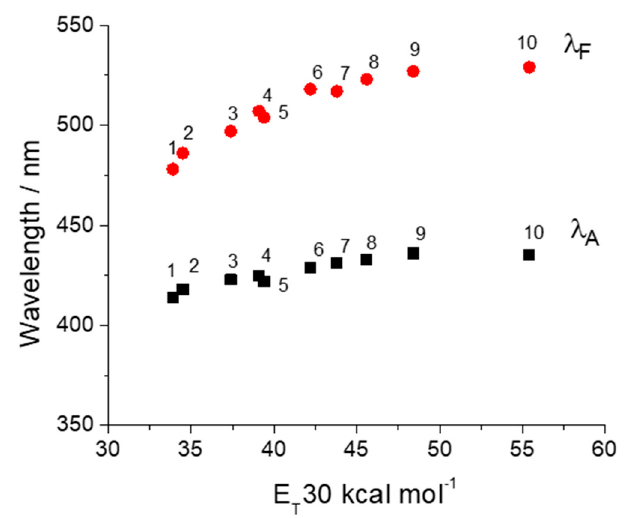
Figure 3. Dependence of absorption and fluorescence maxima of NI3 on the empirical parameter of solvent polarity E T (30): 1-toluene, 2-diethyl ether, 3-tetrahydrofuran, 4-chloroform, 5-dichloromethane, 6-acetone, 7-DMF, 8-acetonitrile, 9-2-propanol, and 10-methanol.